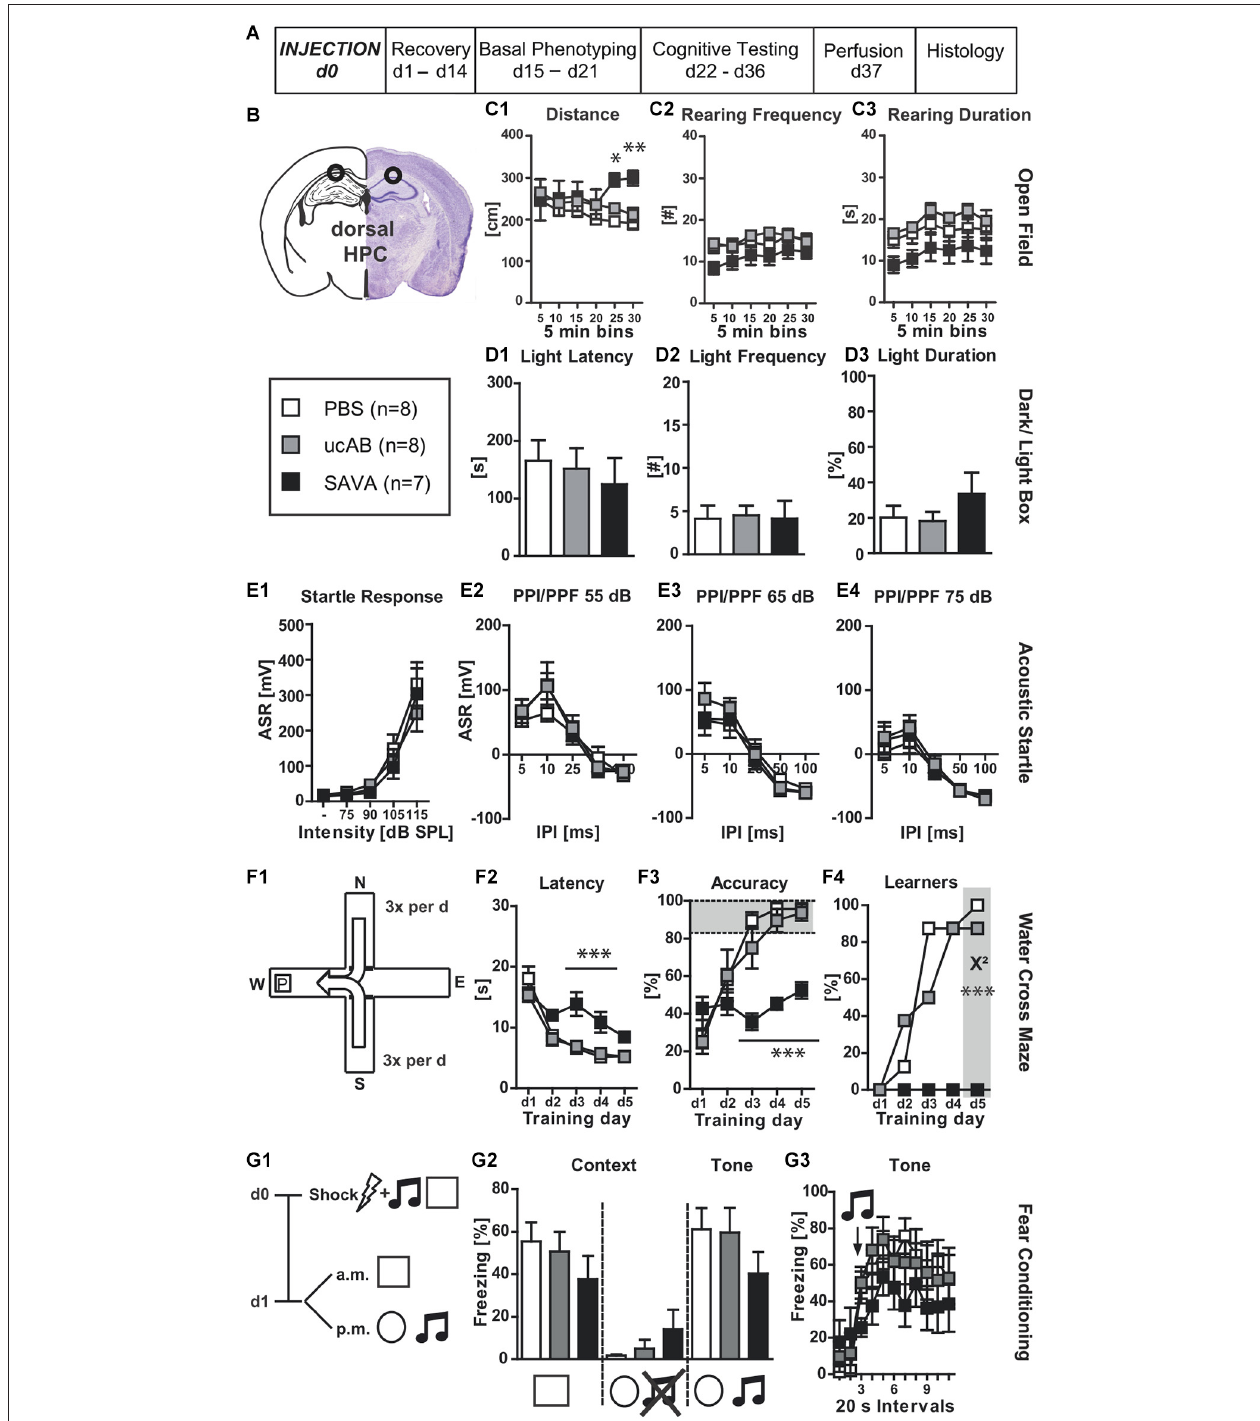
Bregma); groups and sample size for Experiment II ; (C1–3) OF behavior; (D1–3) D-L Box behavior; (E1–4) ASR as basic Input/Output curve and PPI/PPF after a 55, 65, 75 dB pre-pulse, respectively, for 5 different IPIs; (F1) basic schema of WCM; (F2–4) learning parameters for WCM; (G1) timeline for FC: tone-shock pairing on d0; testing for contextual and tone memory in conditioning and novel context on